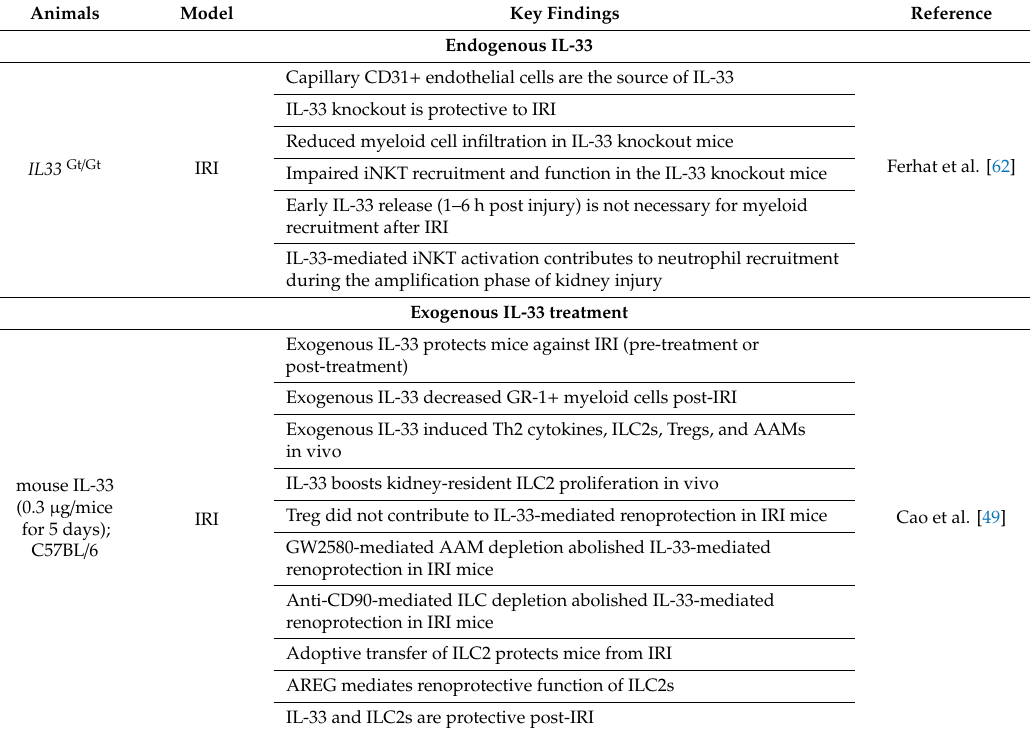
Table 2. E ff ects of endogenous and exogenous IL-33 in AKI